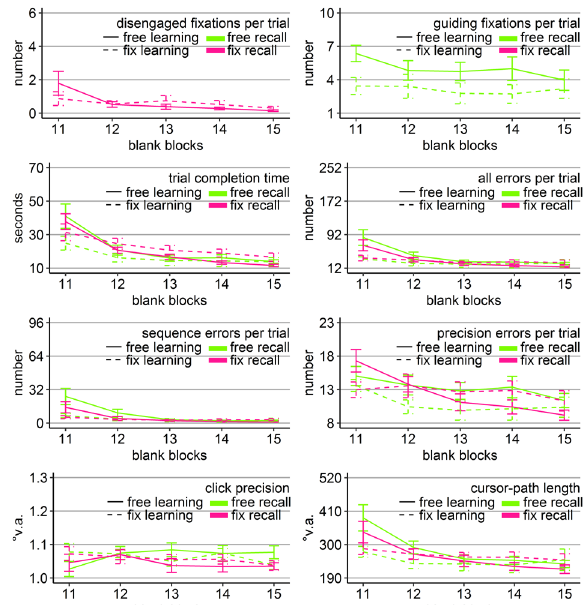
Figure 5. Gaze and performance measures during the recall phase of Experiment 2. The top left plot shows how often participants, who were asked to keep central fixation, disengaged their fixation per trial (y-axis) over the course of the five blank blocks (x-axis) depending on whether they learned the clicking sequence with free gaze (solid line) or with fixed gaze (dashed line). The top right plot shows how many guiding fixations participants, who were allowed to move their eyes freely, performed per trial (y-axis) during the five blank blocks (x-axis) depending on whether they had learned the clicking sequence with free gaze (solid line) or with fixed gaze (dashed line). The six bottom plots show the performance measures trial completion time in seconds, numbers of all errors, sequence errors, and precision errors per trial, click precision in °v.a., and cursor-path length in °v.a. (y-axes) over the course of the five blank blocks (x-axes) for the four group combinations of recall with free gaze (green lines) or fix gaze (pink lines) after learning with free gaze (solid lines) or fix gaze (dashed lines). Error bars represent standard errors of the